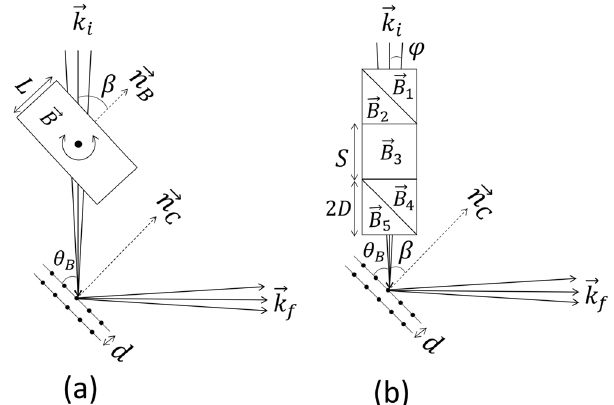
Figure 1. ( a ) A schematic showing the geometry of single-arm neutron Larmor diffraction, where L is the path length of the rectangular field perpendicular to the lattice planes and the magnetic field has intensity B. d is the lattice spacing. ( b ) A schematic showing the single-arm Larmor diffraction with magnetic Wollaston prisms, where the rectangular magnetic field region shown in ( a ) is replaced by two magnetic Wollaston prisms with a rectangular field region in between. S and 2D are the size of the rectangular field region and the Wollaston prisms respectively. The field intensities are B 1 , B 2 , B 3 , B 4 and B 5 respectively, as indicated in the schematic. For (cid:31)(cid:30) (cid:31)(cid:30) these pictures, n C and n B are the normals to the crystal planes and magnetic field boundary